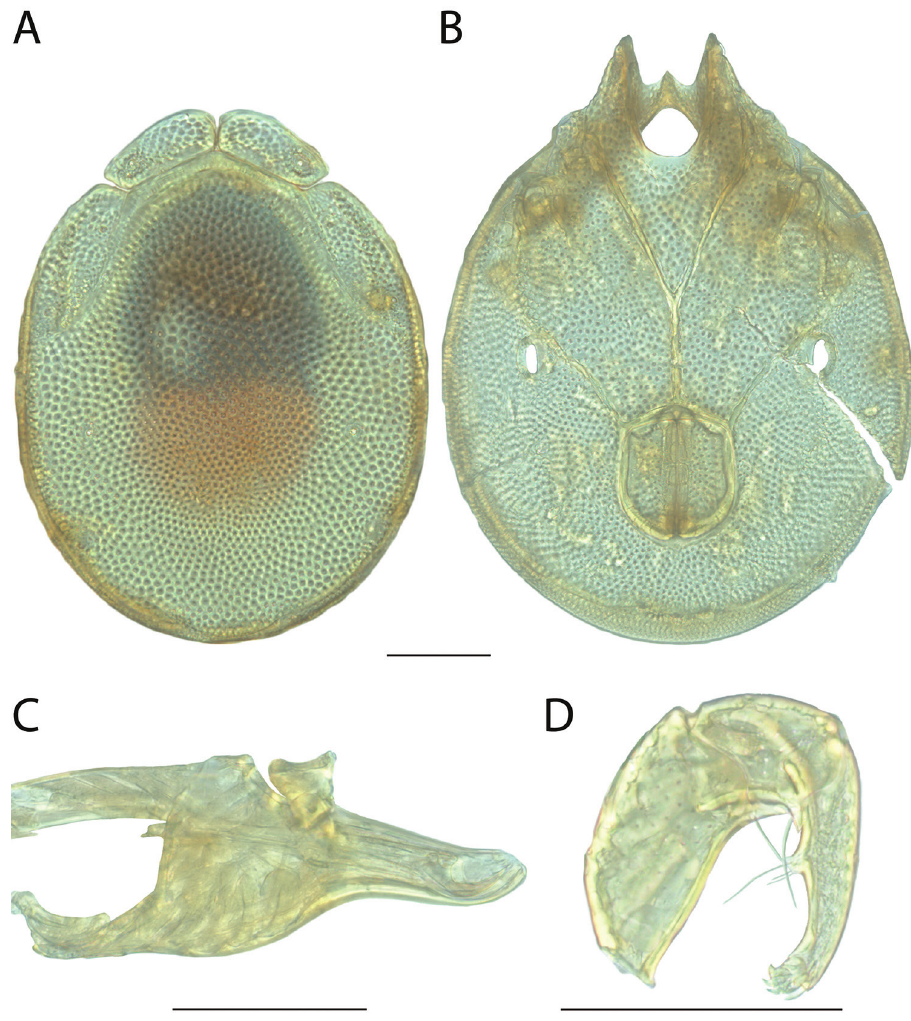
Figure 263. Torrenticola ululata sp. n. male: A dorsal plates B venter (legs removed) C subcapitulum D pedipalp (setae not accurately depicted). Scale = 100